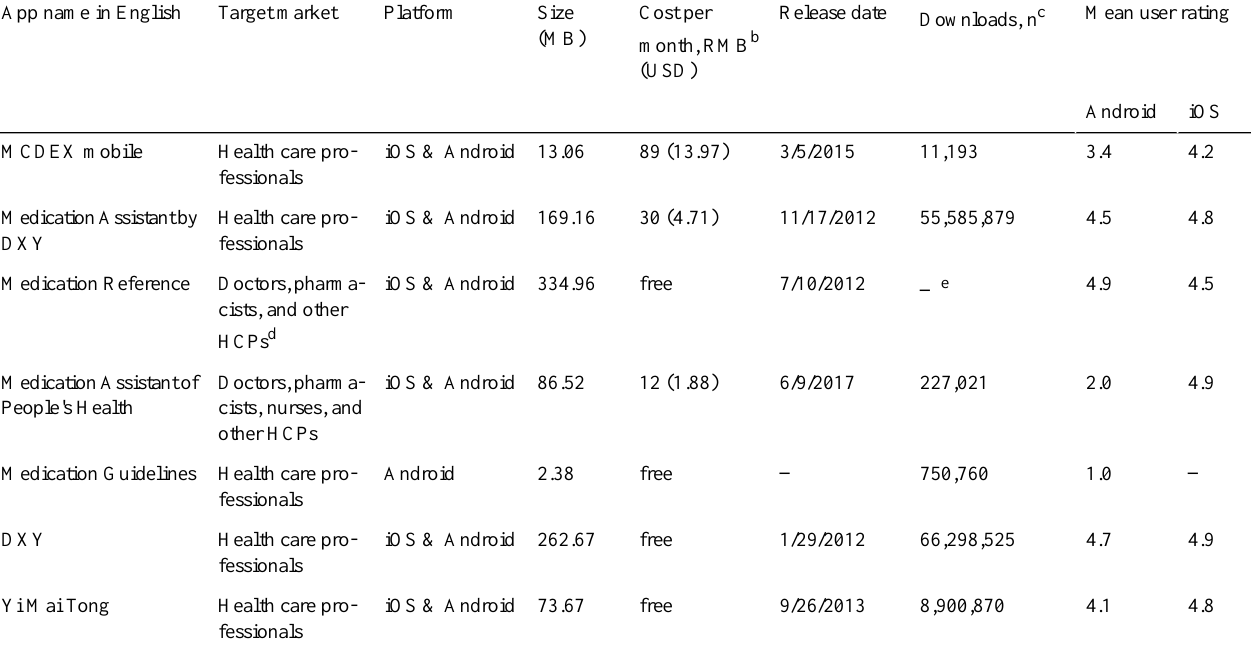
Table 1. General information on the mobile health apps included in the review a .